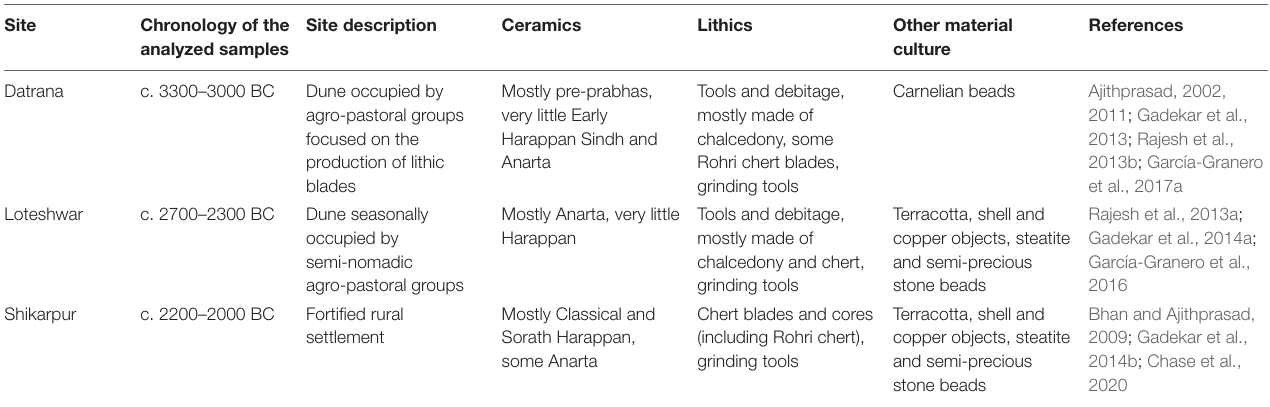
FIGURE 1 | Map of Gujarat showing the case studies (red triangles) and other archeological sites mentioned in the text (green circles). Background map prepared by Francesc C. Conesa. TABLE 1 | Summary of the available archeological information for the deposits where the samples analyzed in this study were